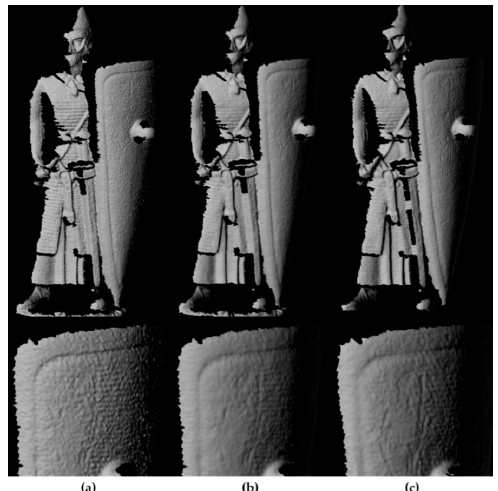
Figure 9. 3D rendering comparisons. ( a ) 3D scan data obtained by active stereo vision; ( b ) 3D scan data applying Nehab’s algorithm using traditional photometric stereo method; ( c ) 3D scan data applying Nehab’s algorithm using re-projection method.